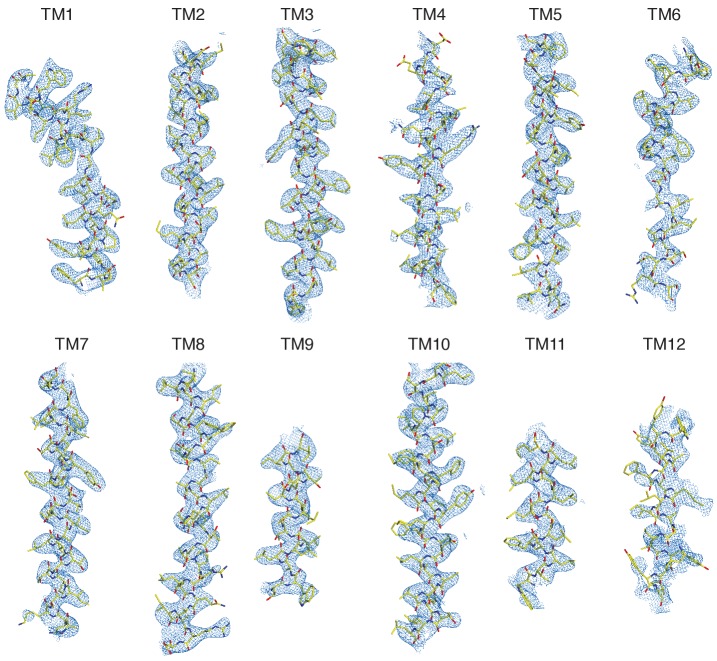
Representative regions of cryo-EM map.Cryo-EM density is shown carved around each transmembrane helix with the atomic model of KCC4 drawn as sticks.